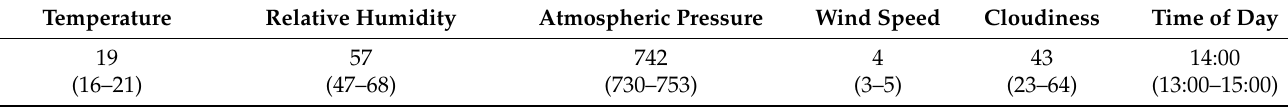
Table 1. Mean outdoor environment variables across experimental